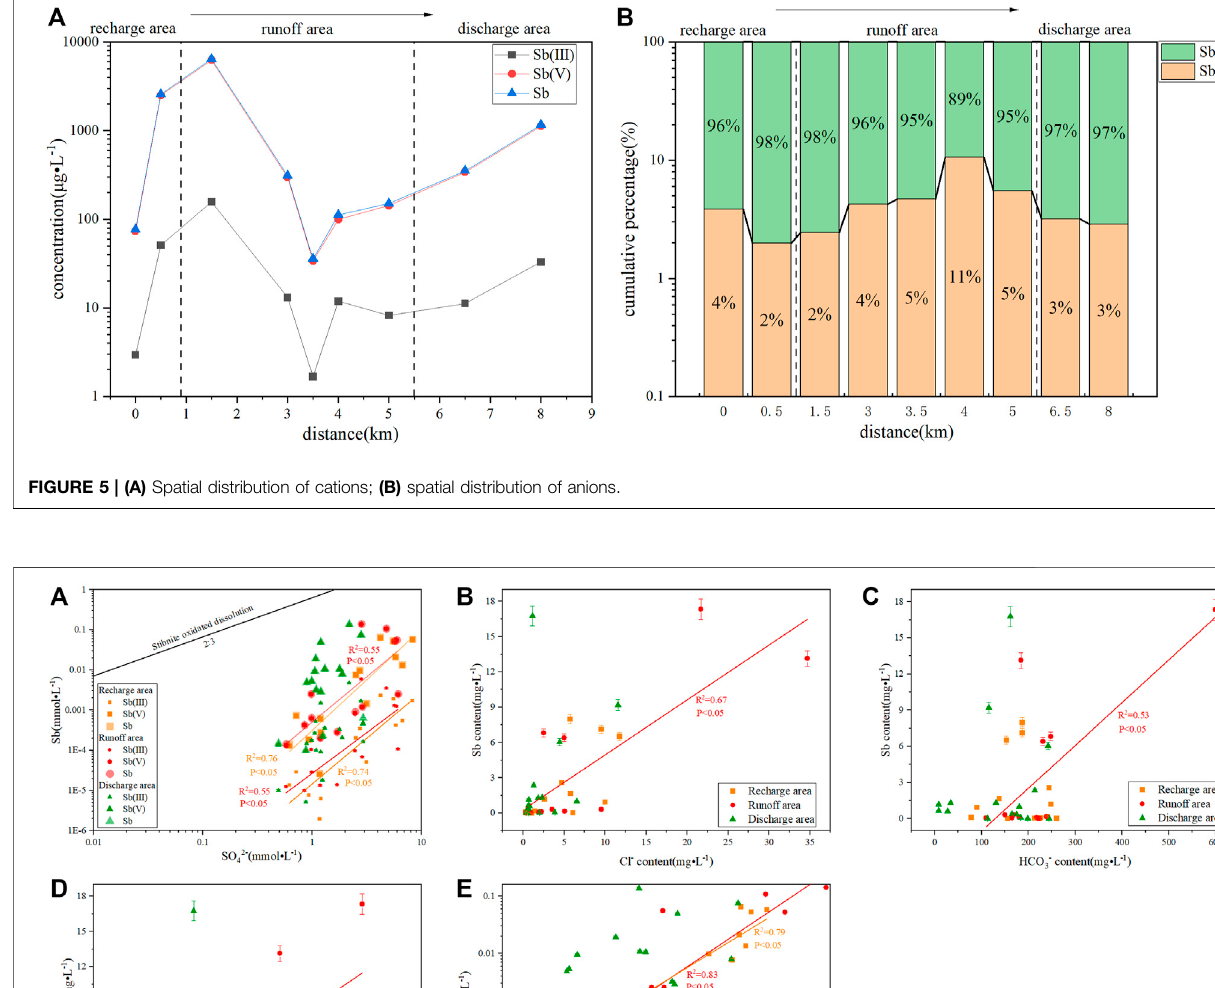
Frontiers in Environmental Science |